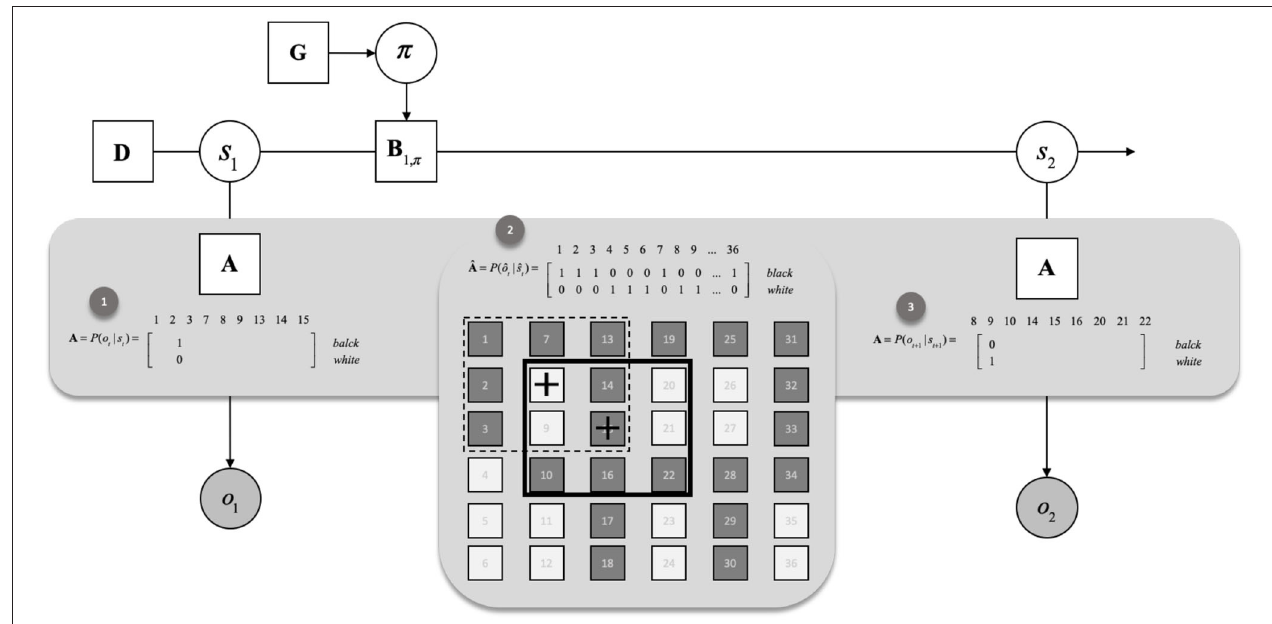
FIGURE 1 | Likelihood remapping. For illustrative purposes, this figure presents a generative process (A hat) made of 36 locations, or states. Each state is associated with an outcome, either black or white. (1) The initial likelihood is defined for an agent that would start in location 8. The likelihood of the generative model is specified based on the 8 locations, or hidden states surrounding the current location, as well as the current location. (2) Based on the inferred policy (e.g., 8 → 15), we move the agent in the generative process, here, to location 15. (3) Indexing the novel surrounding and current location from the generative process, we remap the likelihood that will be used at t + 1 to infer the state and the